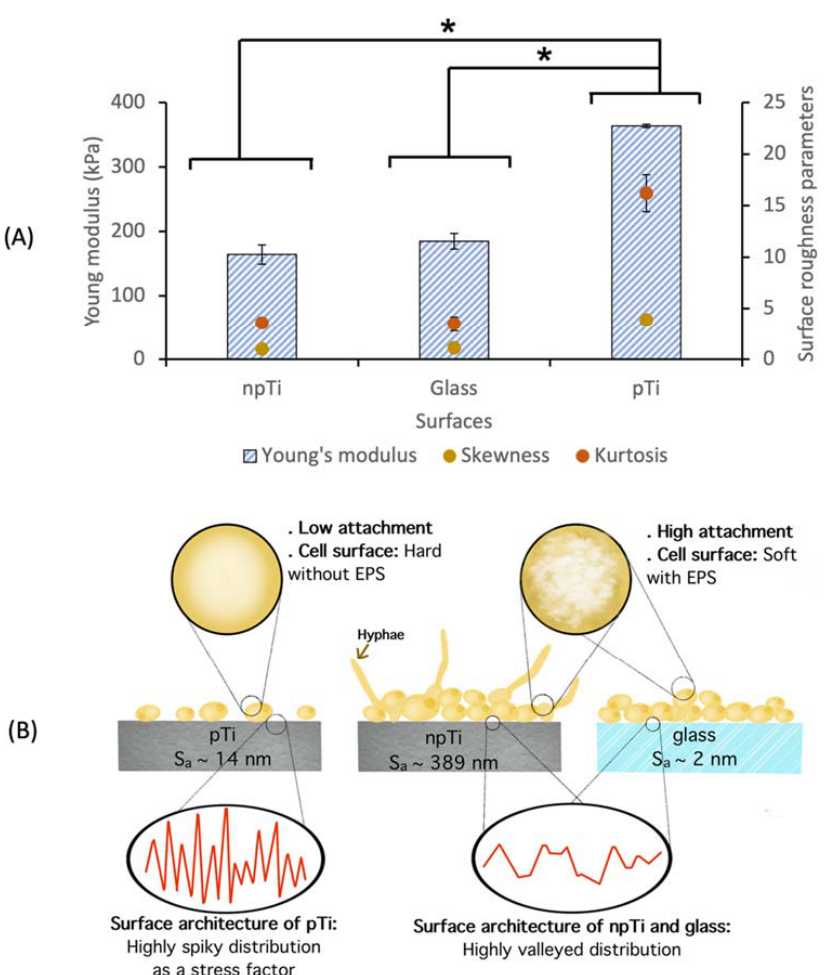
Figure 5. Correlation between surface roughness parameters (right y -axis) and mechanical properties of C. albicans cells (left y -axis). ( A ) The rigidity of C. albicans cells attached on npTi, glass, and pTi surfaces was analyzed after a 3-day incubation period. The values of the two surface roughness parameters, such as skewness and kurtosis, highlight the differences in surface architecture. Skewness and kurtosis reflect the proportion of valleys or peaks and the proportion of high peaks and hollow valleys, respectively. An increased cell rigidity was observed on surfaces with increased kurtosis values. A statistically significant difference in surface roughness parameters and Young’s modulus of attached C. albicans cells on pTi surfaces, compared to those on Ti and glass surfaces, is indicated by the asterisks (* p < 0.05). ( B ) Comparison of mechanical properties of C. albicans cells when settling on surfaces of varied in roughness and architecture. Hyphae were formed after 7-day incubation with npTi surfaces, as reported in a previous work